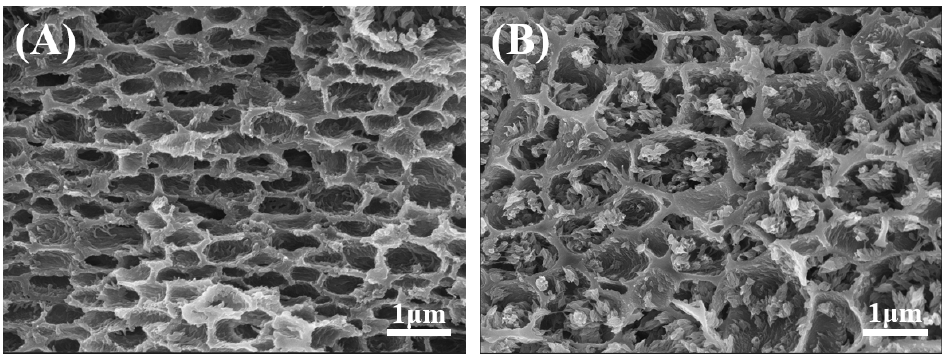
Figure 4. SEM pictures of PDLC ( A ) and PD&SLC ( B ).